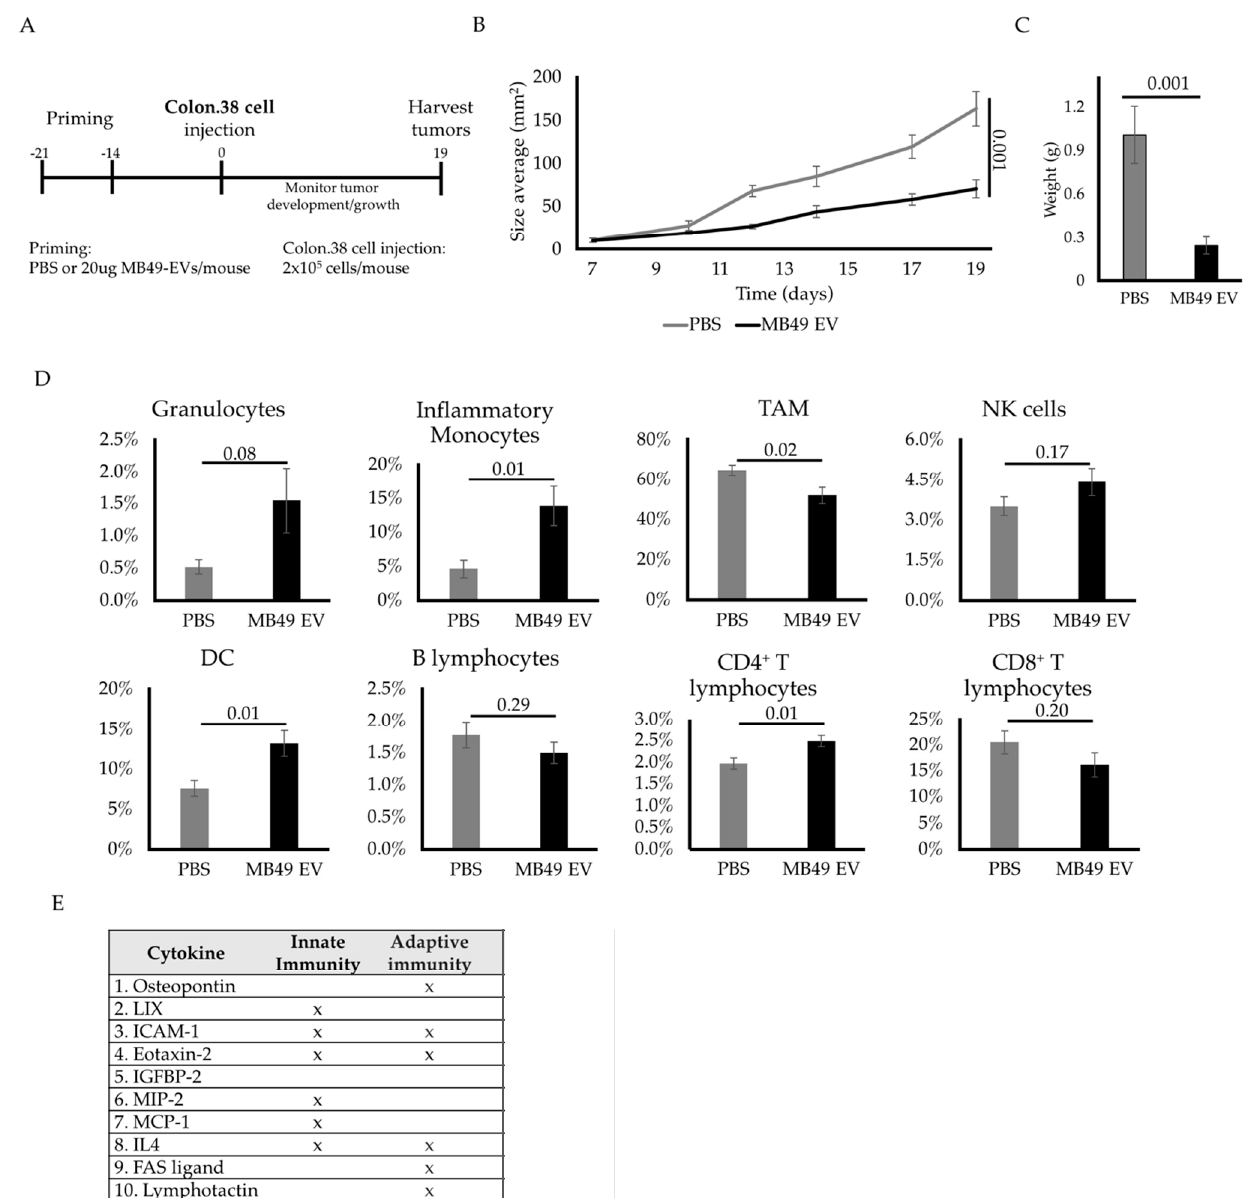
Figure 5. MB49 EV priming promotes both innate and adaptive immune cell-mediated antitumor immune responses. ( A ) Diagram of in vivo experimental design timeline. ( B ) Subcutaneous Colon.38 tumor growth curve after MB49-EV priming (mm 2 ). ( C ) Bar graphs of the averaged harvested tissue weight at day 19. ( D ) Bar graphs comparing averaged percentages of infiltrated immune cell subpopulations at day 19 in control mice and MB49-EV-primed mice as measured by flow cytometric analysis. Identified immune cells are shown as follows: granulocytes, inflammatory monocytes, tumor-associated macrophages, natural killer cells, dendritic cells, B lymphocytes, CD4 + T lymphocytes and CD8 + T lymphocytes. The n number is 8 on each group. Error bars show standard error. Statistical significance was calculated by independent Student t -test comparing the respective two groups at the time. ( E ) Identified MB49-EV-contained cytokines and their roles in innate and adaptive immunity: osteopontin [28], LIX [29], ICAM-1 [30], Eotaxin-2 [31], IGFBP-2 [32], MIP-2 [33], MCP-1 [27], IL4 [34], PAS Ligand [35] and Lymphotactin [36].